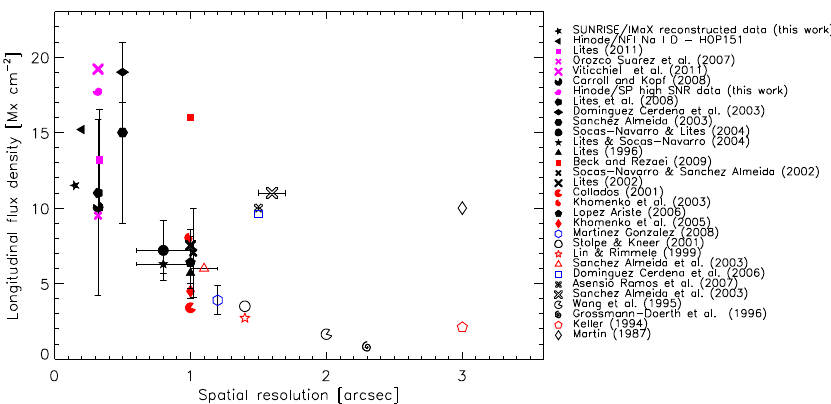
Fig. 27 Compilation of quiet Sun longitudinal flux densities reported in the literature against spatial reso- lution of the observations. Each of the symbols represents a measurement, as indicated on the right. Blue colors mark flux values derived from simultaneous observations in visible and near-IR lines. Red stands for near-IR lines alone. Error bars are present when the authors provide them or when different values for